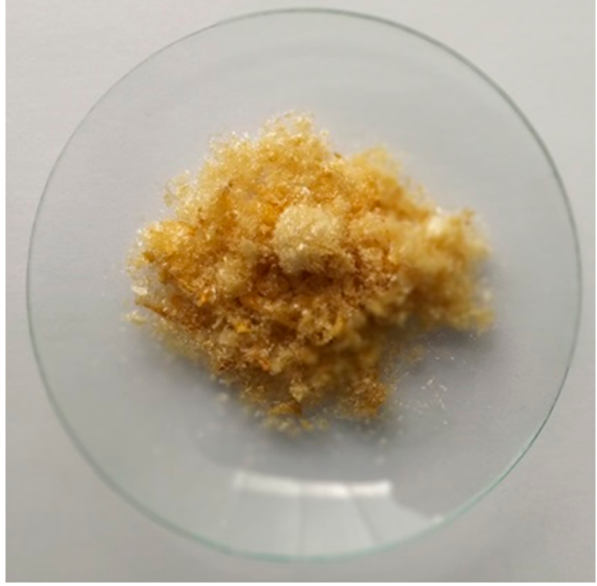
Figure 1. Water extract of black currant leaves after lyophilization.